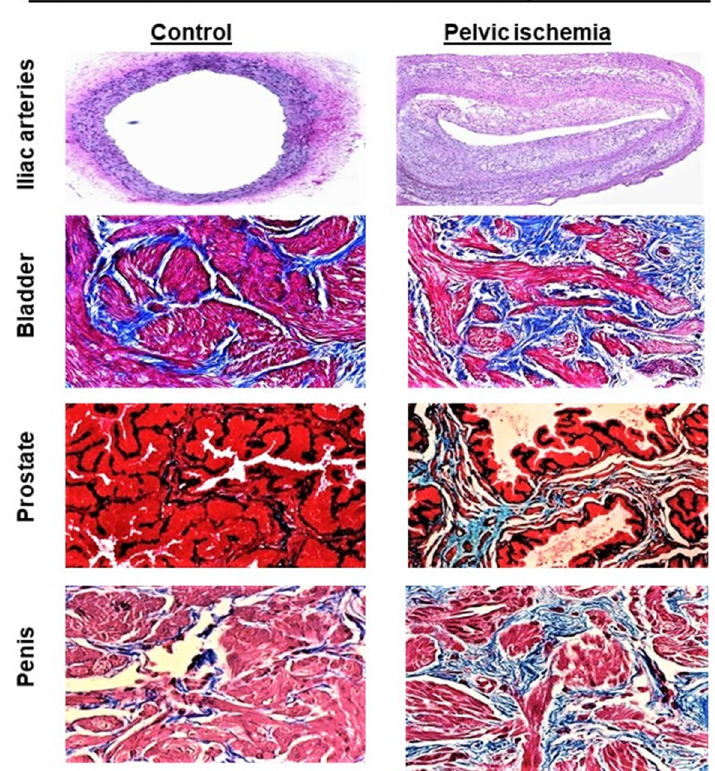
Figure 1. This figure shows that pelvic ischemia resulting from arterial atherosclerosis provokes simultaneous histological changes in the bladder, prostate, and penile erectile tissues. Iliac artery samples from animals with pelvic ischemia showed marked thickening of arterial intima and media layers and diminished arterial luminal size, suggesting atherosclerotic occlusive disease. Histologic assessment of tissue samples from the control bladders showed normal proportion of smooth mus ‐ cle (red stain) and connective tissue (blue stain) with no indication of excessive collagen accumula ‐ tion or fibrosis. Tissue samples from the ischemic bladder revealed dense bundles of collagen, sug ‐ gesting diffuse fibrosis, loss of smooth muscle cells, and potential replacement of smooth muscle by connective tissue. Assessment of prostatic tissues showed swelling and thickening of the stroma, diminished smooth muscle density, accumulation of collagen, distorted glands with compressed epithelium lining, and the formation of large intraluminal spaces in the ischemic prostate tissues in comparison with control prostatic tissues. Consistent histological changes were evident in penile erectile tissue from animals with pelvic ischemia in comparison with controls. The erectile tissue smooth muscle content (stained red) was dramatically reduced, and connective tissue (stained blue) increased in the ischemic erectile tissue, suggesting loss of smooth muscle and diffuse fibrosis. The histology figures are shown at 40× magnification. These figures are taken from our previous publi